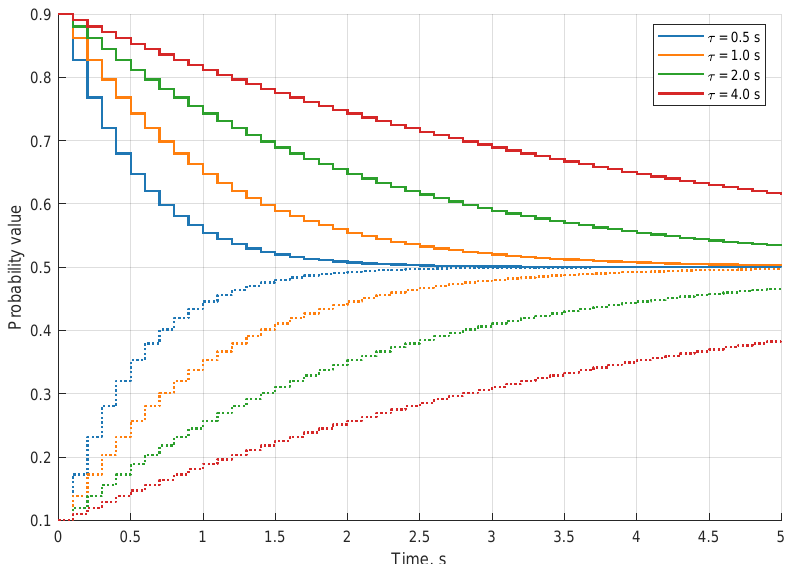
Figure 3. Decaying process of the occupied cell with p = 0.9 (solid lines) and free cell p = 0.1 (dotted lines) for different mean lifetimes. The decay is applied with 10 Hz